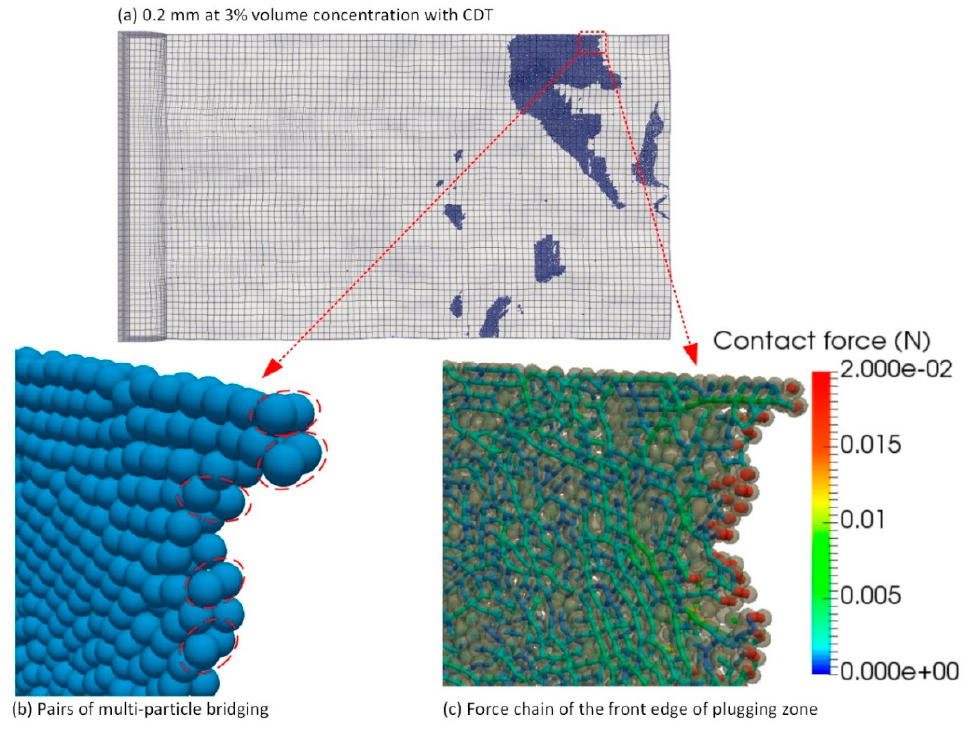
Figure 17. The multi-particle bridging and force chain of LCM particles.